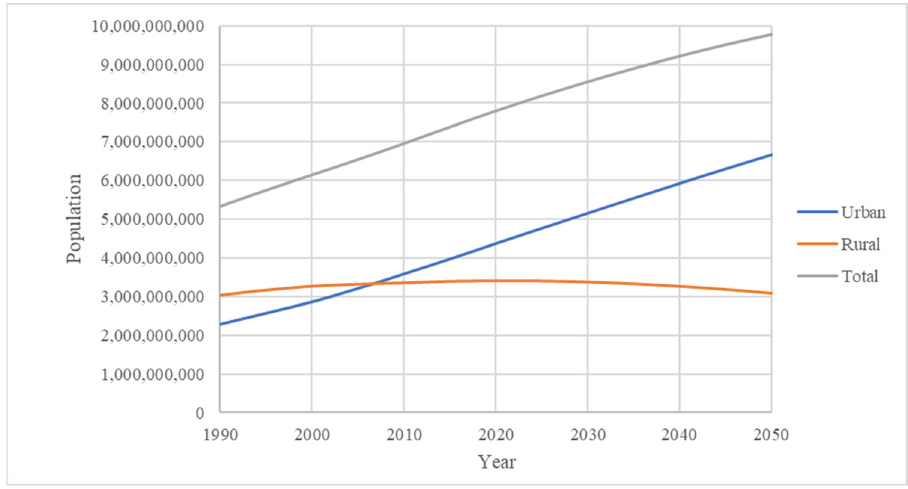
Figure 1. Urban, rural, and total global population.